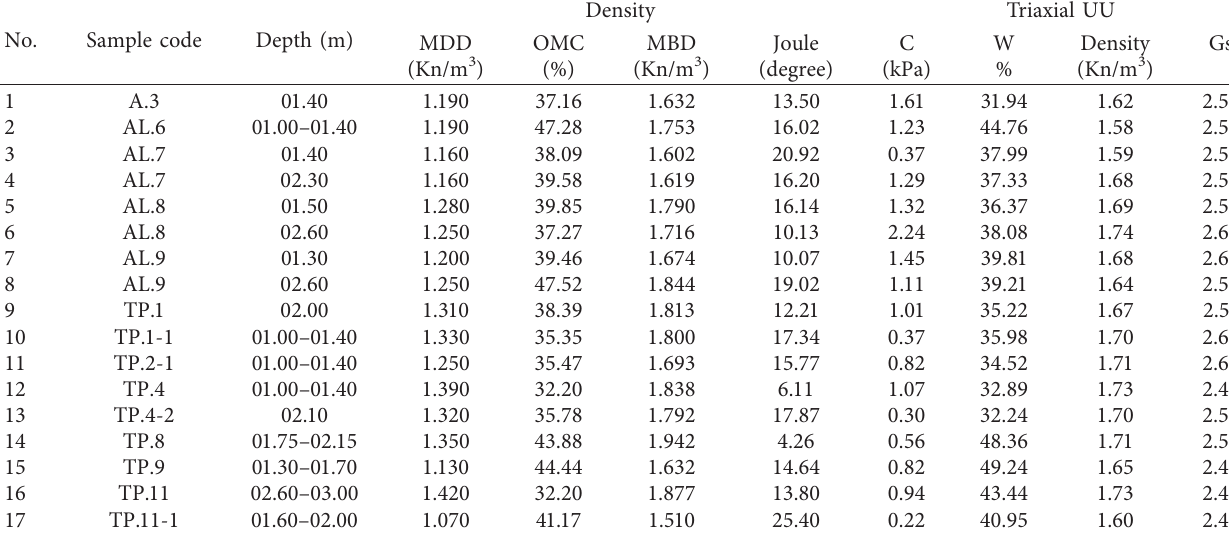
Table 1: Soil sample testing result.